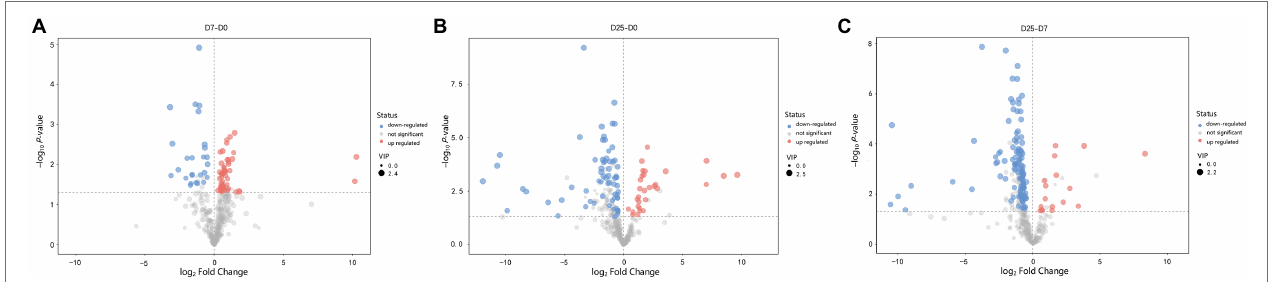
FIGURE 4 | Volcano plots of liver tissue sample metabolites. (A) Shows the D7 group compared to the D0 group. (B) Shows the D25 group compared to the D0 group. (C) Shows the D25 group compared to the D7 group. The red dots represent metabolites that are upregulated, the blue dots represent metabolites that are downregulated, and the gray dots represent metabolites that do not change significantly. D0, overfeeding for 0 days; D7, overfeeding for 7 days; D25, overfeeding for 25